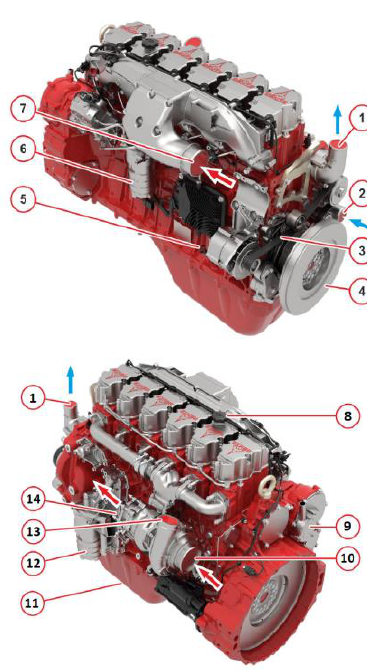
Fig. 13. Engine structure: 1 – coolant outlet, 2 – coolant inlet, 3 – v-rib belt, 4 – torsional vibration damper, 5 – oil dipstick, 6 – fuel filter, 7 – boost